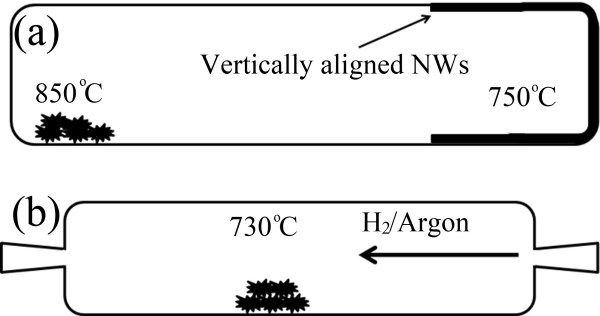
Schematic illustration for the refinement (a) and hydrogenation (b) processes of Mo6SyIzNWs templates.